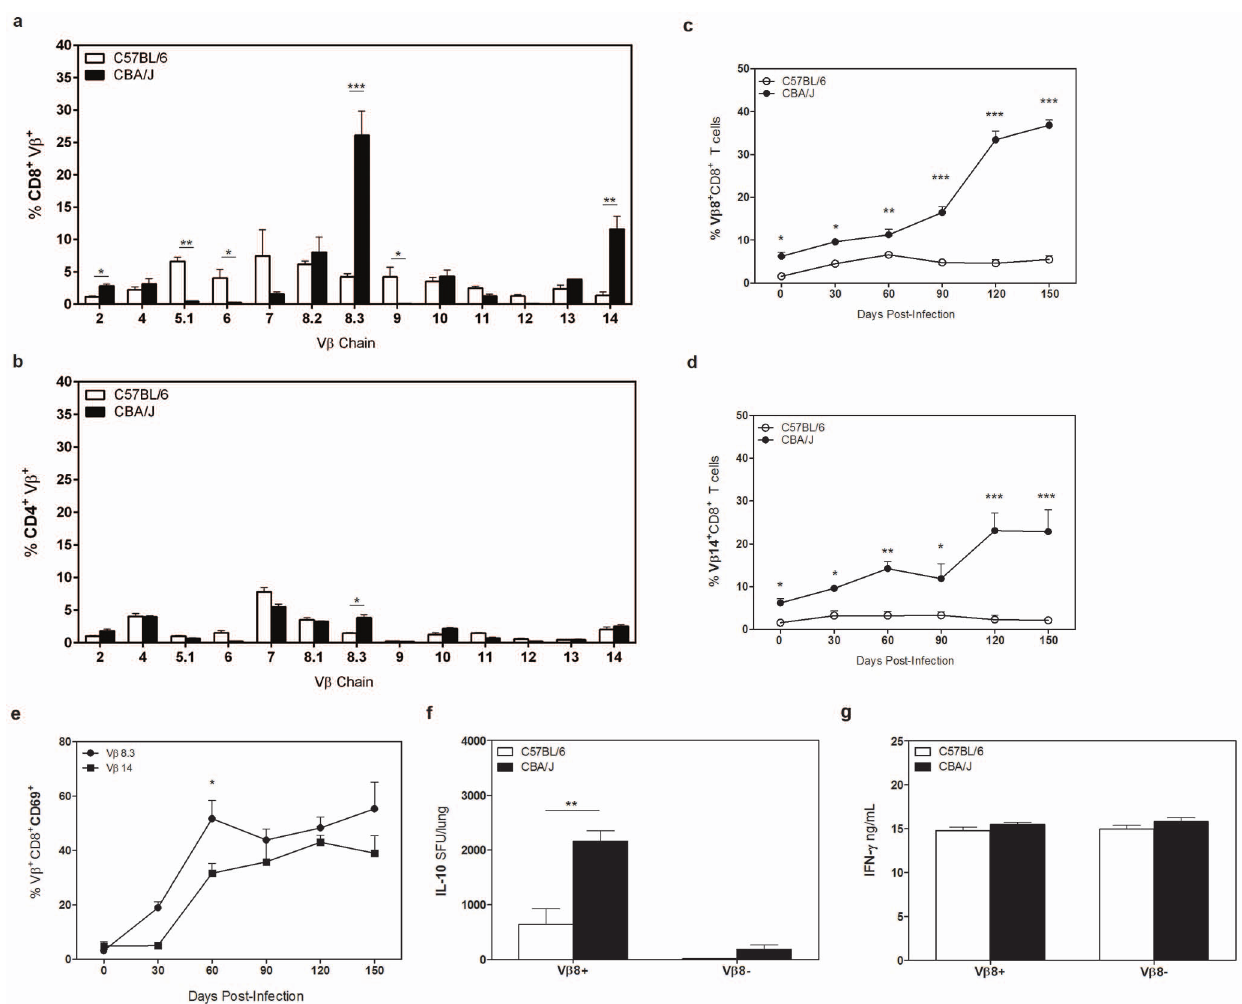
Figure 4. V b TcR expression in CBA/J and C57BL/6 mice. C57BL/6 and CBA/J mice were infected with an aerosol dose of Mtb and at various timepoints post-infection lungs were removed and processed for flow cytometry. Percentages of CD8 + ( a ) or CD4 + ( b ) T cells expressing specific V b TcRs at day 120 post-infection. Percentages of CD8 + T cells expressing V b 8 ( c ) or V b 14 ( d ) TcR over the course of Mtb infection. ( e ) Percentages of V b 8 + or V b 14 + CD69 + CD8 + pulmonary T cells over time. ( f ) V b 8 + and V b 8 neg T cells from day 120 post-infection were cultured for 72 hr with anti-CD3/ CD28 and IL-10 SFU determined by ELISpot. ( g ) Supernatants from (a) were analyzed for IFN- c levels by ELISA. Data representative of at least two independent experiments with 4 mice per group per timepoint. * p , 0.05, ** p , 0.01, *** p , 0.001 as obtained by Student’s t test.